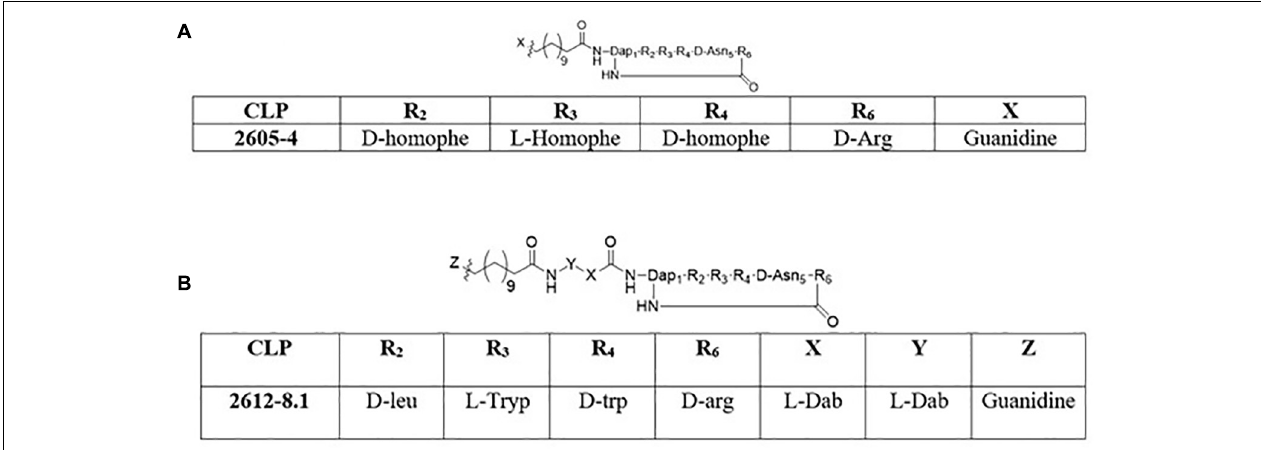
FIGURE 1 | Structures of cyclic lipopeptides: (A) 2605-4 (B) 2612-8.1.